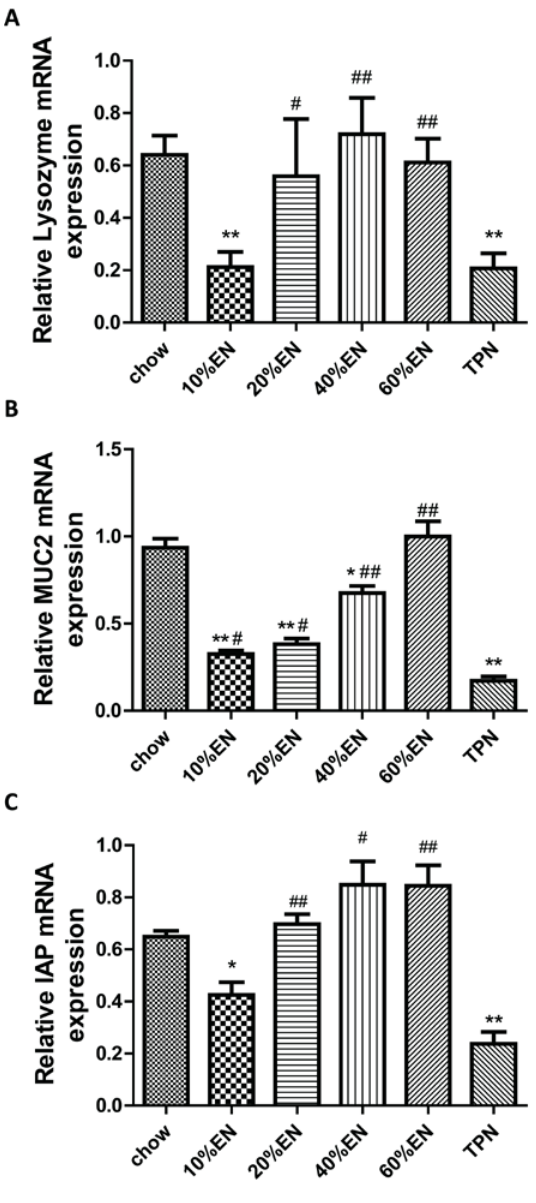
Figure 5. Reverse transcription quantitative polymerase chain reaction analysis of the ( A ) expression levels of innate immunity products in the ileal tissue. ( A ) Lysozyme; ( B ) mucin 2 (MUC2) and ( C ) intestinal alkaline phosphatase (IAP). Data are represented as the mean ± standard error of the mean (SEM). * p < 0.05 vs. chow. ** p < 0.001 vs. chow. # p < 0.05